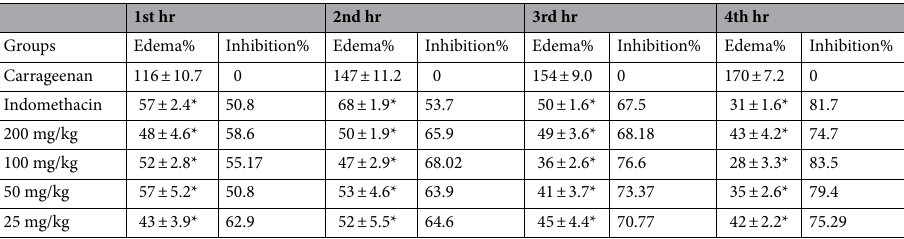
Table 8. Effect of optimized extract and indomethacin (10 mg/kg) on carrageenan-induced rat hind paw edema. *Statistically significant p < 0.05.